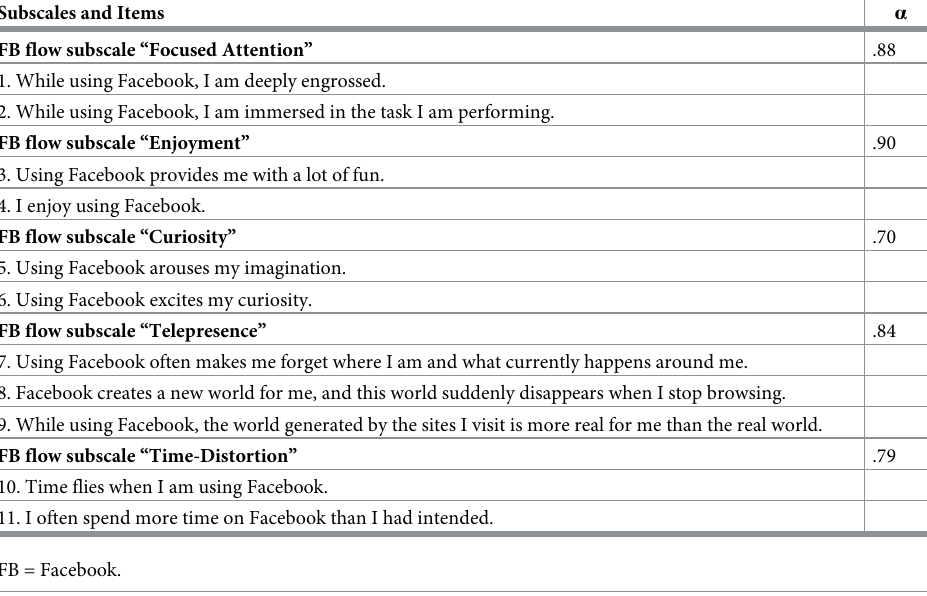
Table 1. “Facebook flow” questionnaire (modified version of [21]). Subscales and